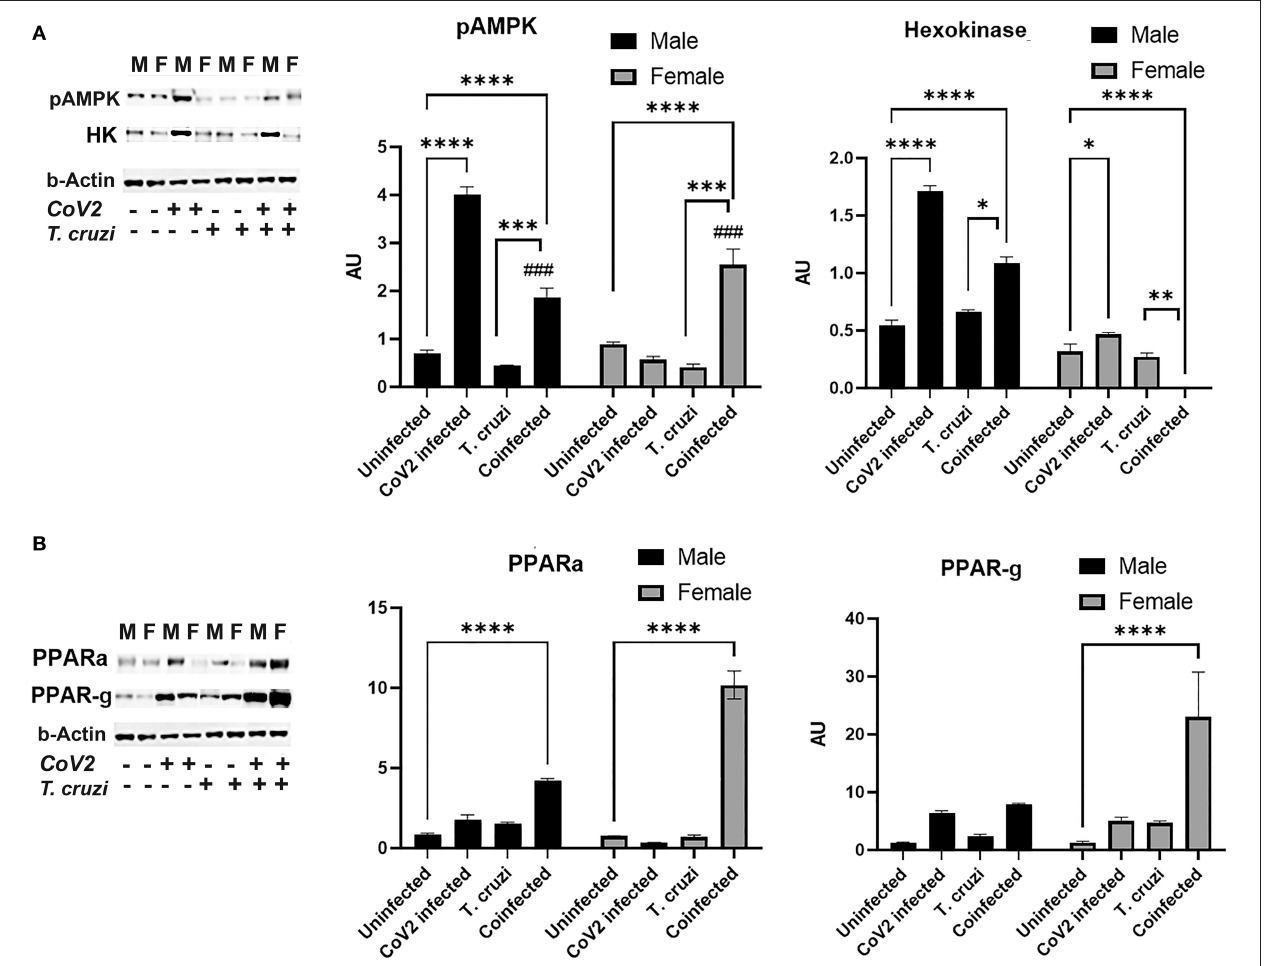
FIGURE 7 | Immunoblot analysis of markers of glucose and lipid metabolism in the hearts of CoV2 infected, T. cruzi infected, and coinfected huACE2 mice. Immunoblot images of (A) markers of glucose metabolism (pAMPK and hexokinase II) and (B) markers of lipid metabolism (PPAR α and PPAR γ ). β -Actin was used as loading control. Fold changes in the protein levels normalized to β -Actin are shown as bar graphs (A dot plot displaying individual data points is presented in Supplementary Figure 4 ). The error bars represent standard error of the mean. * p < 0.05, ** p < 0.01, *** p < 0.001 and **** p < 0.0001 compared to uninfected sex matched mice ( n = 4/sex/group) ( ### p ≤ 0.001 for comparisons between CoV2 infected and coinfected mice) (M, male; F,